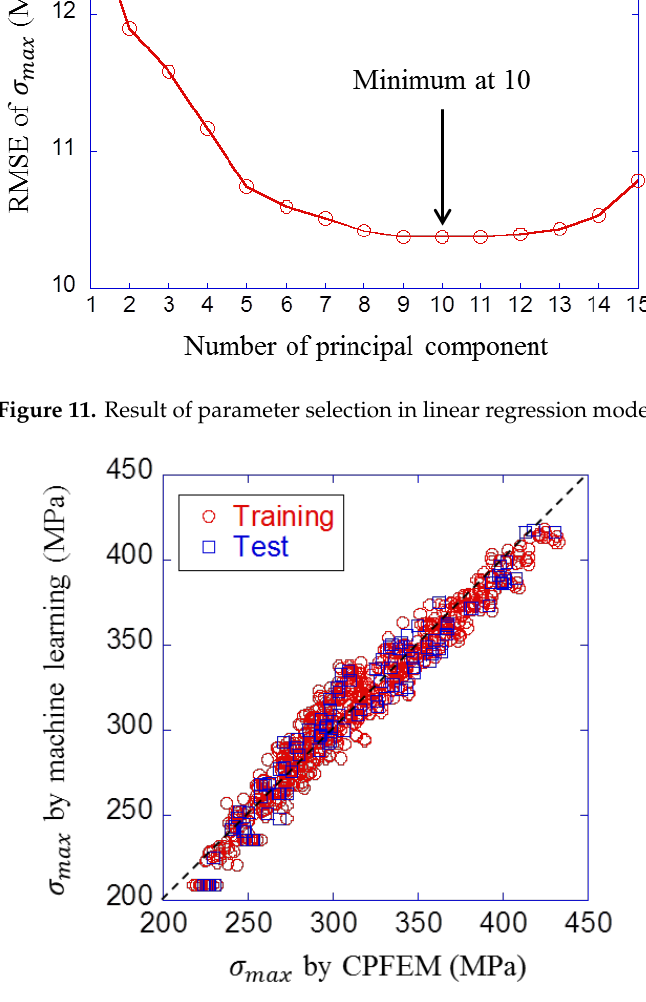
Figure 12. Prediction result of linear regression model with the best combination of principal